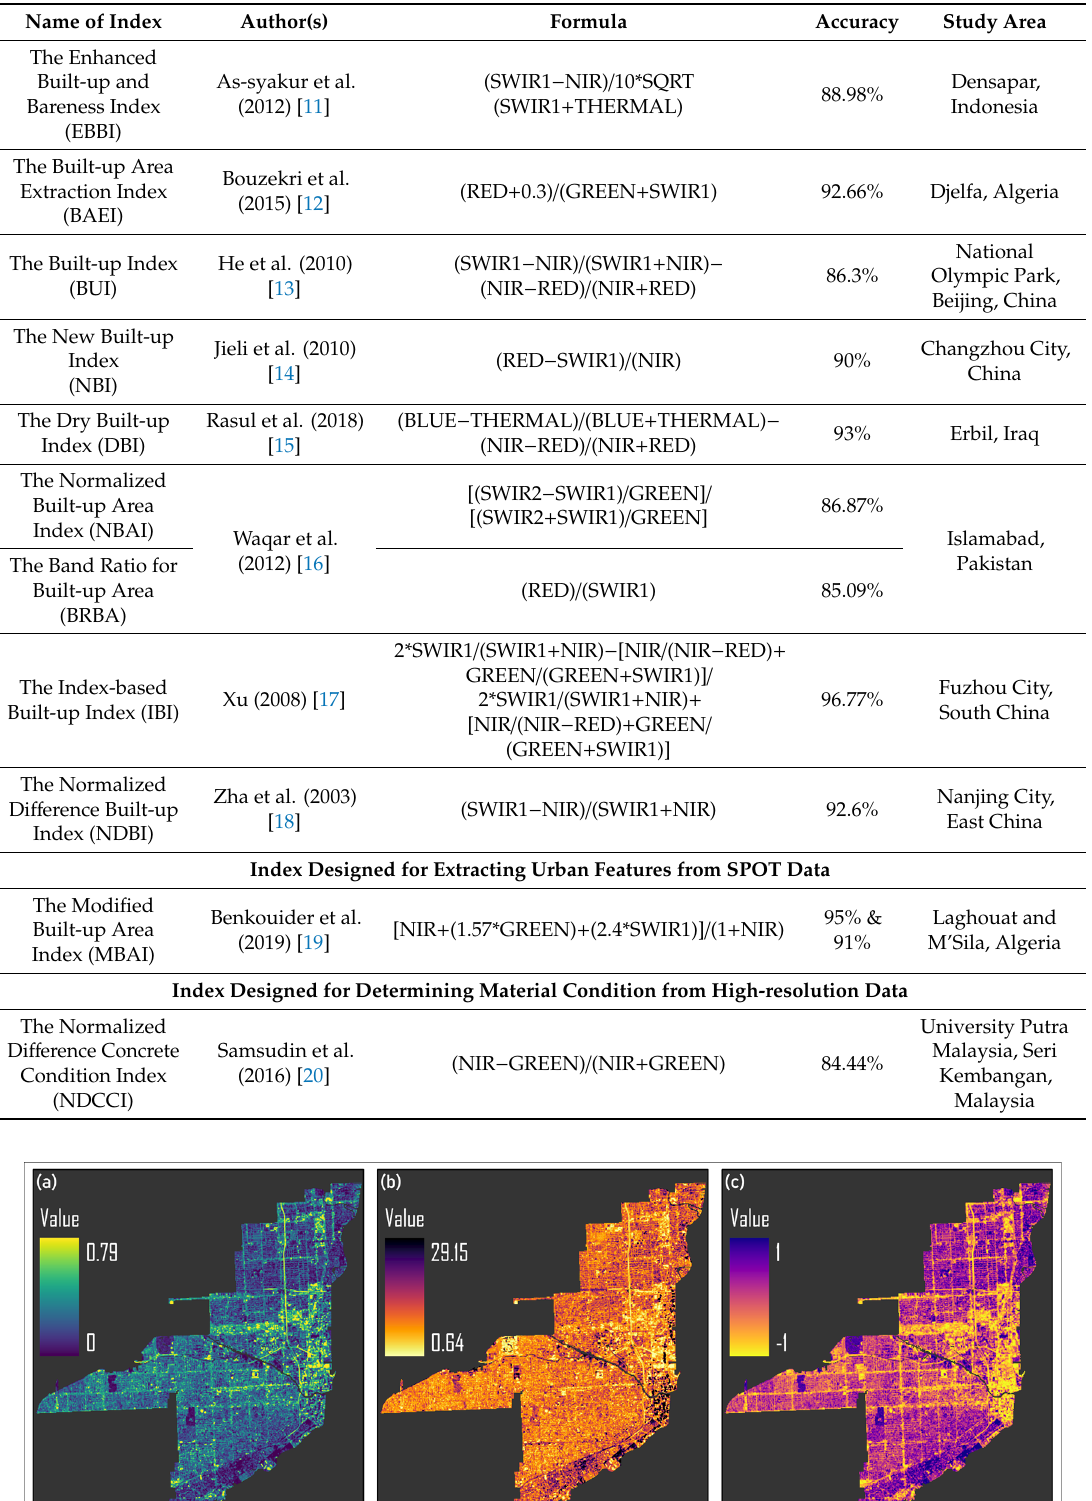
Table 2. Built-up indices found in scientific journals evaluated for unique spectral properties.